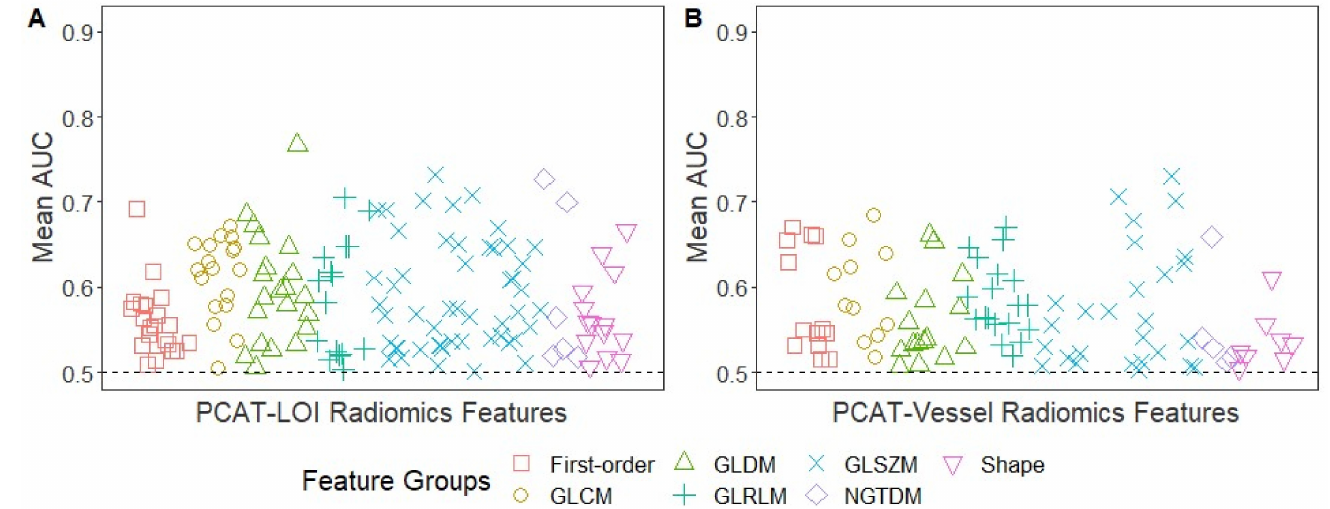
Figure 3. Univariate CCTA-feature analysis for predicting IVOCT-TCFA. Manhattan plot of PCAT- LOI ( A ) and PCAT-Vessel ( B ) of the mean AUCs for the identification of coronary vessels with IVOCT-TCFA. The number of radiomic features with AUC > 0.5 for identification of coronary vessels with IVOCT-TCFA was 147/293 (50.2%) for PCAT-LOI and 99/341 (29.0%) for PCAT-Vessel. Of the 147 PCAT-LOI-radiomics features with AUC > 0.5, 14 (9.5%) were shape features, 21 (14.3%) were first-order statistics, and 112 (76.2%) were texture-based features (GLCM: 18, GLDM: 21,